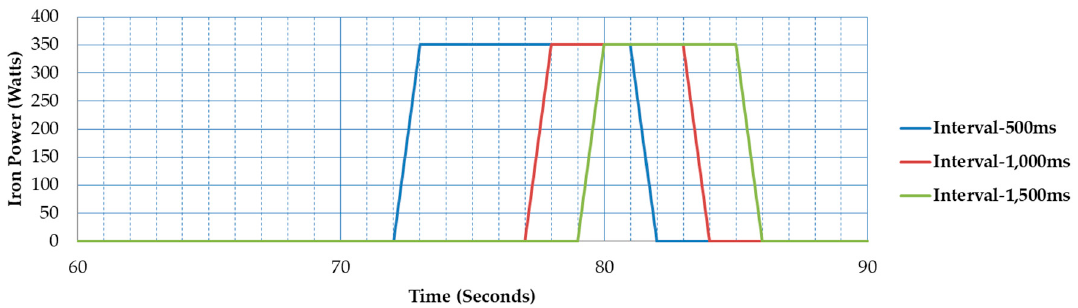
Figure 10. Iron power consumption simulated on a 10-s basis.